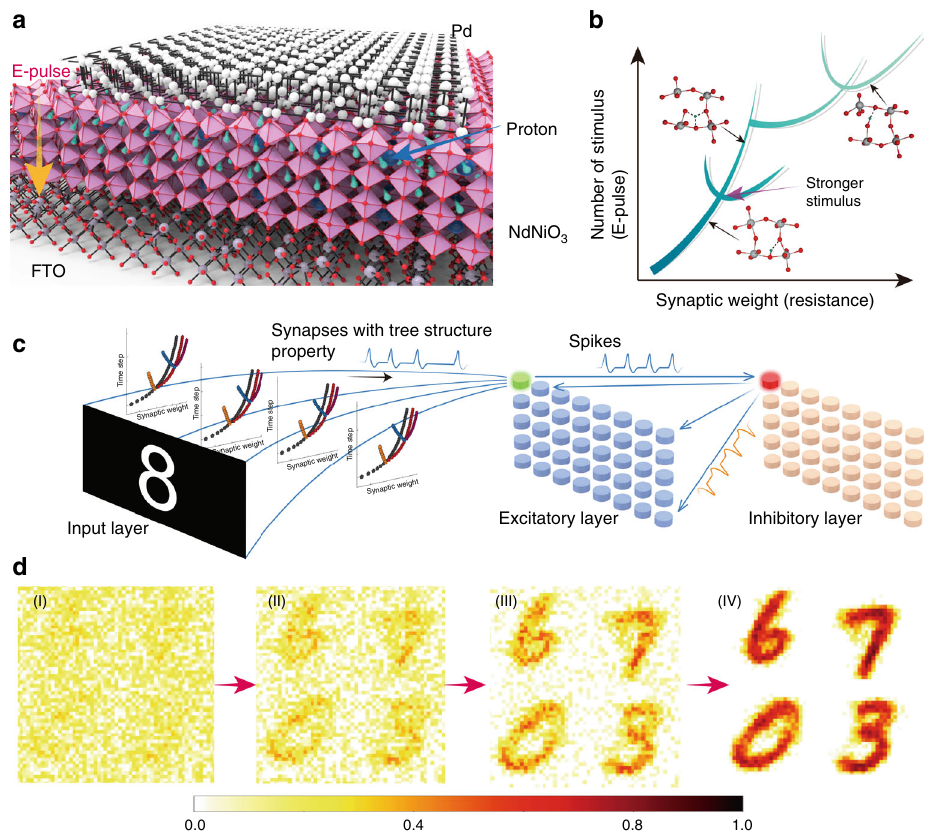
Fig. 1 Perovskite neural trees and their use in neuromorphic learning. a Schematic fi gure of the perovskite nickelate NdNiO 3 device with Pd as top electrode and fl uorine-doped tin oxide (FTO) as bottom electrode. The top electrode serves also to catalytically dope hydrogen into the near-surface region of the perovskite. Applying electric fi eld pulses can move the protons in the lattice which also changes the local Ni valence state and electron-electron correlation, thus modulating the device resistance in a systematic manner. b Schematic of the tree structure showing synaptic strength (resistance) as function of number of stimulus (electric pulses). The electrical resistance of the perovskite devices can be modulated with consecutive electric pulses. The snapshots schematically show the movement of protons in the lattice, which leads to different resistivity values. c Architecture of spiking neural network for handwritten digit recognition. Each input image pixel is assigned to one input neuron. Input layer generates Poisson ’ s distributed spike train depending on the pixel intensity values, which potentiates the membrane potential ( V mem ) of excitatory layer neuron. These spikes are propagated from input to excitatory layer through synapses which learns using spike time dependent plasticity (STDP) learning rule. Once membrane potential reaches a threshold ( V thresh ), the neuron generates a spike and synapse weights are updated. The tree structure graph represents how synaptic weight changes with input strength. Different curves correspond to different constant inputs. d Evolution of digit learning using the tree-like synapses. Step (I) shows the synapse weights at initial stages of learning, (II) and (III) show weights after learning from 10,000 and 30,000 training images, and (IV) is the fi nal learned weights after training on 60,000